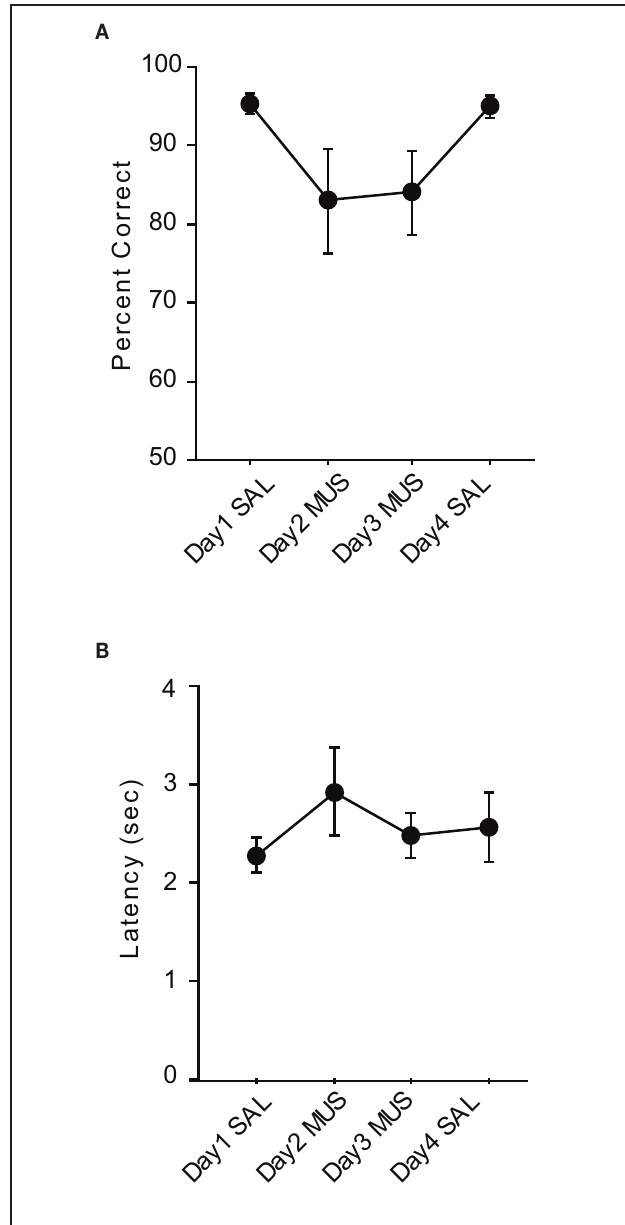
FIGURE 5 | Performance in the VPD task. (A) Rats with SAL injections in the hippocampi showed almost perfect performances with little variances and also showed robust performances (approximately 85% correct) with MUS injections compared to the chance-level performances in the VCRS tasks with MUS infusions. (B) Latency measures were not different between SAL and MUS conditions. All graphs show mean ±